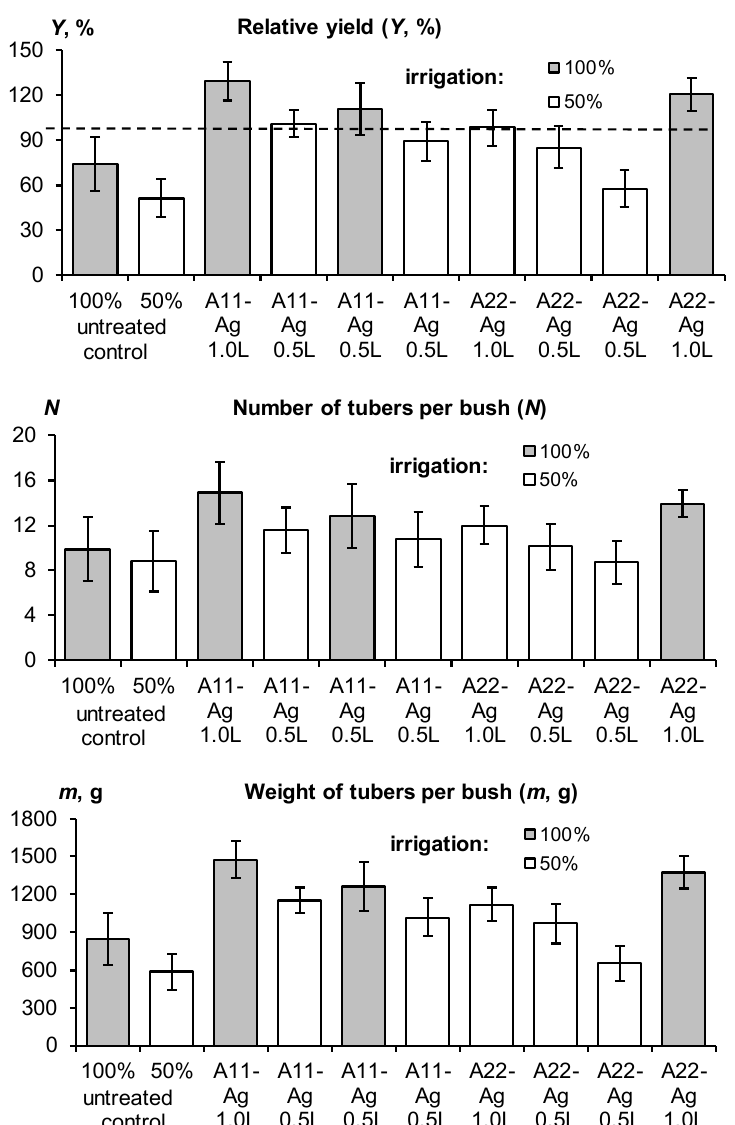
Figure 11. Yield and its components for the Santana potato variety under the influence of irrigation and gel-forming soil conditioners (Uzbekistan, serozem, furrow irrigation, 2020). The dotted line (100%) is the potential yield of 40 t/ha.